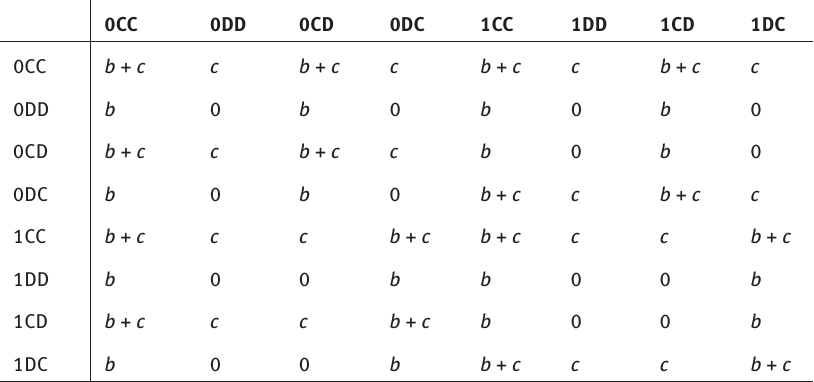
Table 4: The Prisoner’s Delight game with pre-play signaling and conditional behavior. Strategies are coded as follows: signal sent (‘0’ or ‘1’), behavior conditional on receiving a ‘0’, behavior conditional on receiving a ‘1’. For example, 1CD sends signal ‘1’, responds to signal ‘0’ with social behavior and to signal ‘1’ with spiteful behavior.